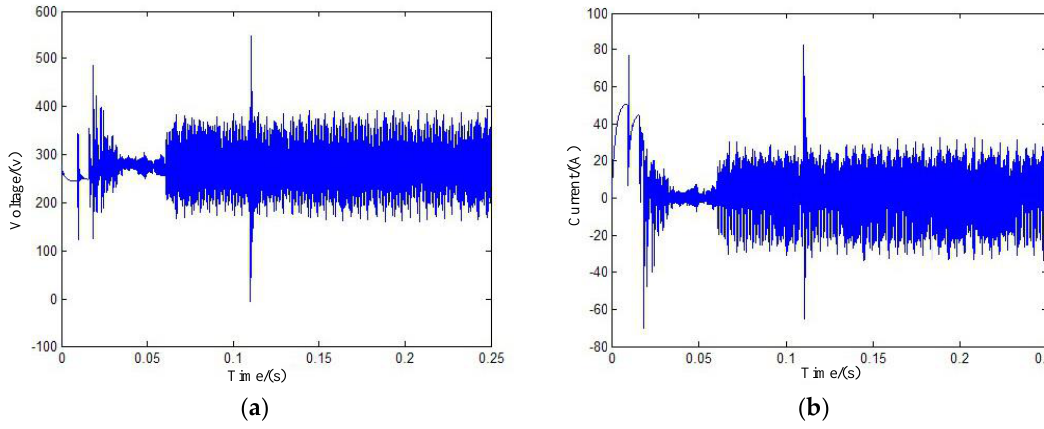
Table 2. Simulation parameters of PMSM.